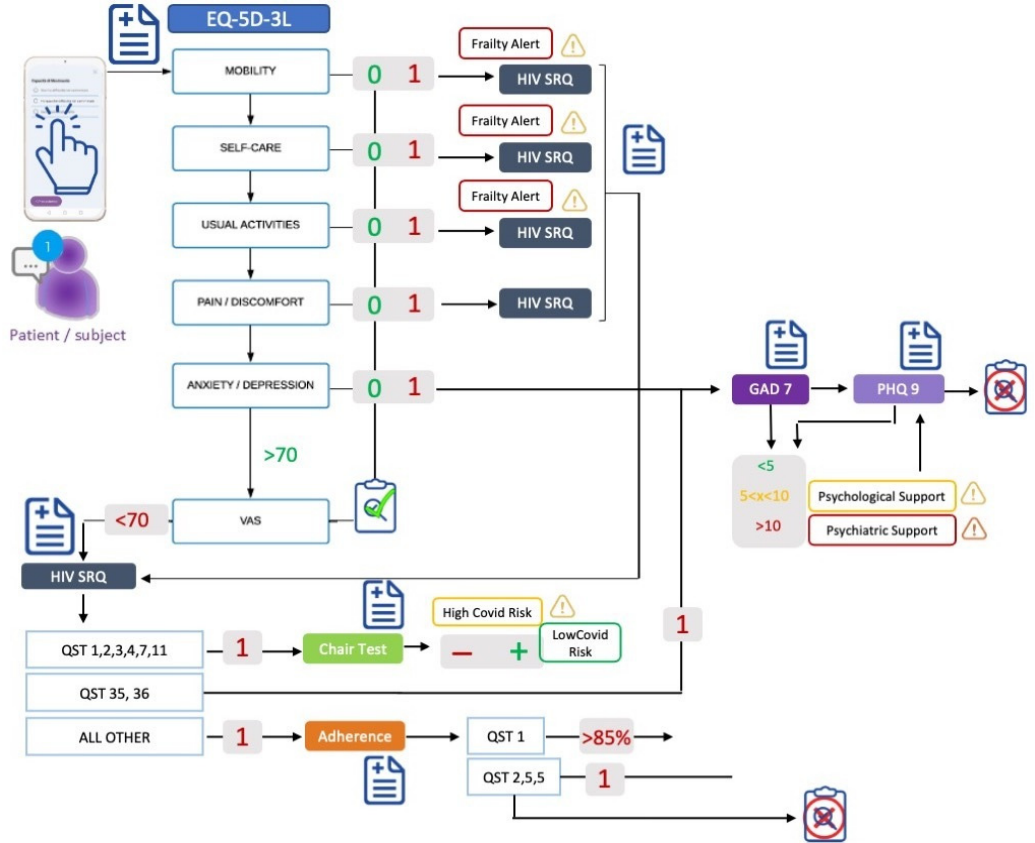
Figure 1. Questionnaires triggering system. The patient is sent a monthly notification to answer the EQ-5D-3L [18] questionnaire. If an alteration in any of the domains of the questionnaire is reported, the patient is automatically notified of a more specific questionnaire to which the altered domain refers: HIVSRQ [19], GAD-7 [20], PHQ9 [21]. If the EQ5D VAS is <70%, then all the above questionnaires are notified, including the treatment adherence questionnaire [22]. With regard to HIVSRQ, if symptoms compatible with SARS-CoV-2 infection are reported, the patient is asked for an in-depth investigation of COVID and risk of hospitalization (chair stress test, CST). In case of alteration to each questionnaire, a report of need for intervention is sent to the attending physician (psychological support, psychiatric support, intervention on symptoms, intervention on low adherence to ART, intervention on COVID-19 risk).